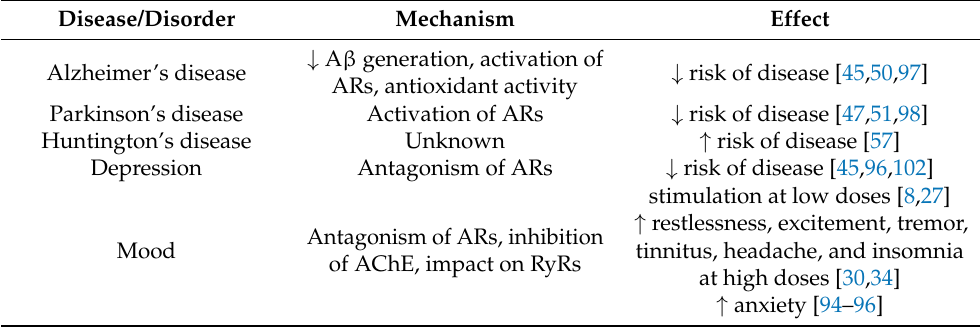
Table 1. The main effects of caffeine action on the nervous system and the most likely mechanisms of its